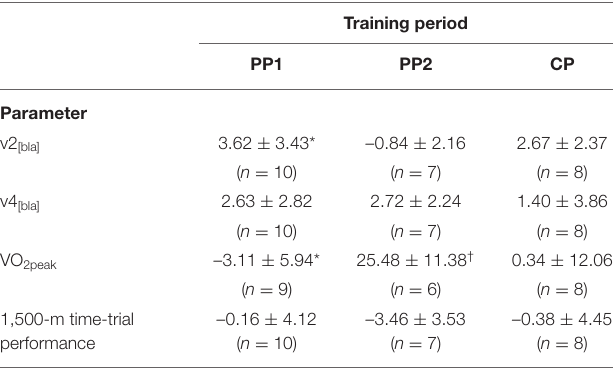
TABLE 5 | Back-transformed means (in %) ± standard deviations for the percentage of each parameter related to performance and training period. Training